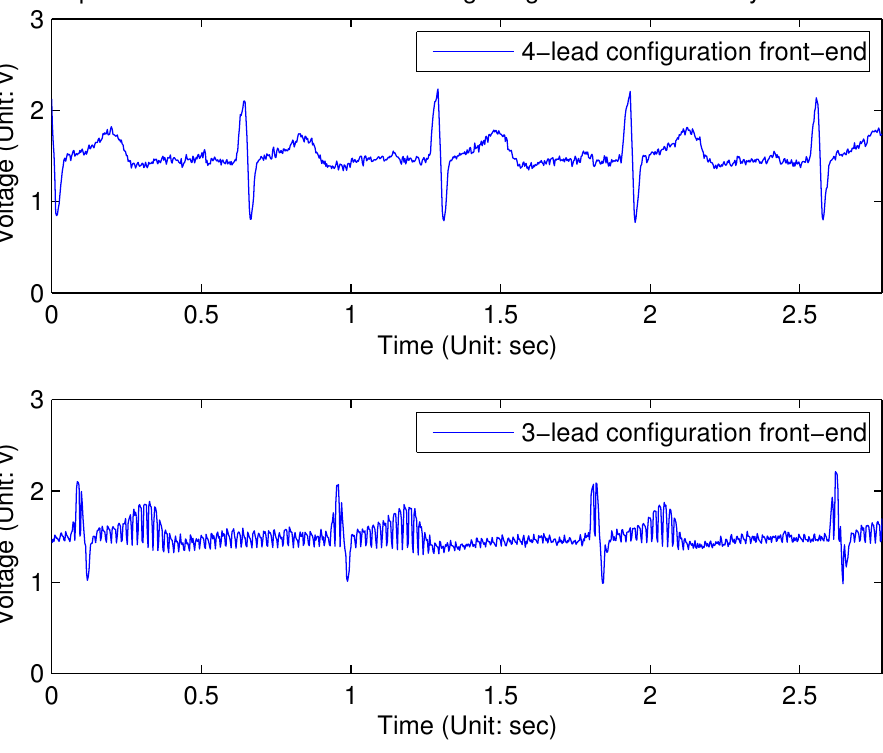
Figure 8. ECG waveforms using different driven right leg circuits in the noisy environment. The charts show a three-second